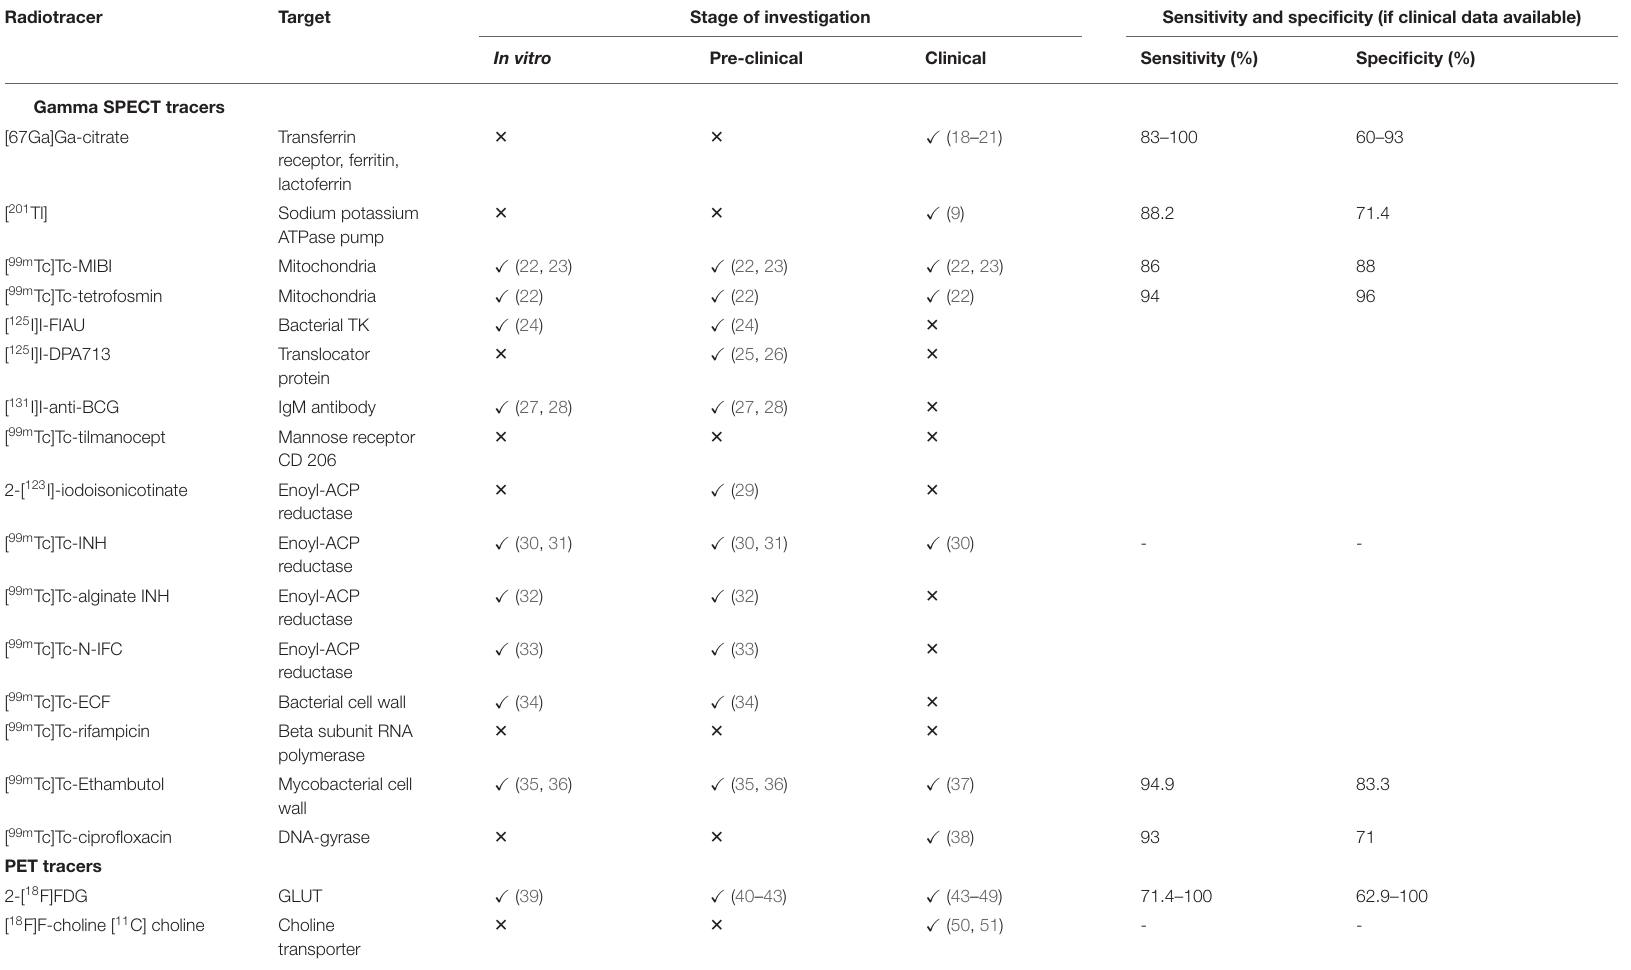
TABLE 1 | An overview of the tracers used in imaging and characterising TB (apart from Gallium-68-labelled